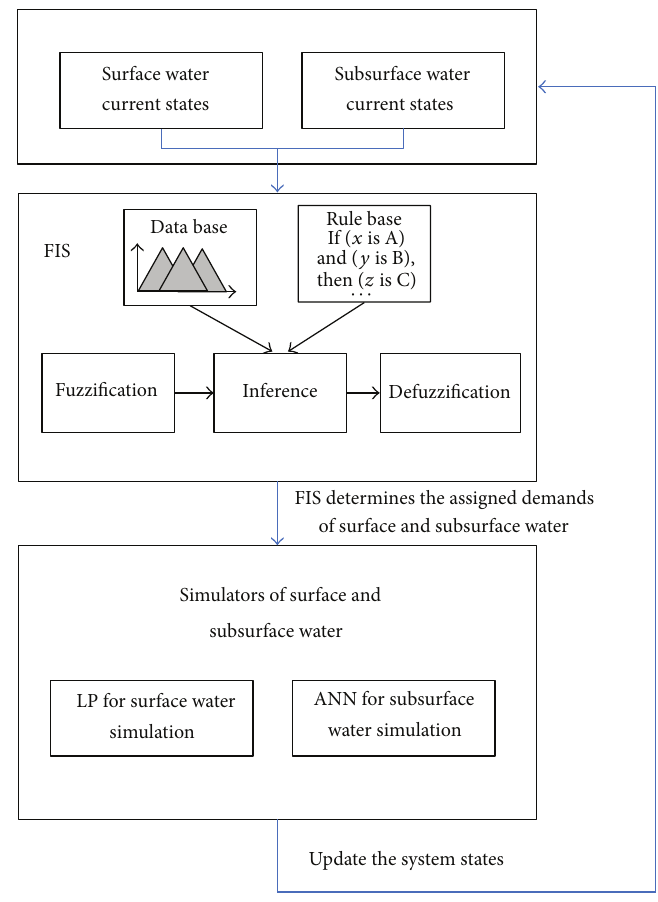
Figure 1: Flowchart of the FIS conjunctive use